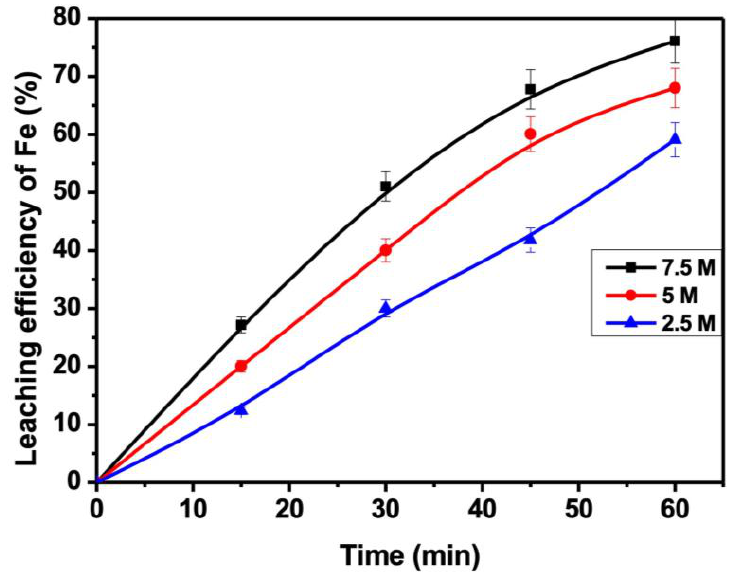
Figure 5. The effect of acid concentration on leaching efficiency of Fe. Conditions: particle size, 150 µm; solid – liquid ratio, 1:10; agitation speed, 350 rpm; agitation time, 60 min; temperature, 80 °C.